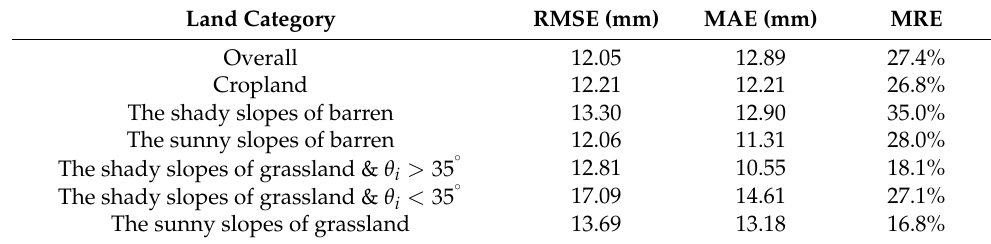
Table 6. Original model inversion accuracy